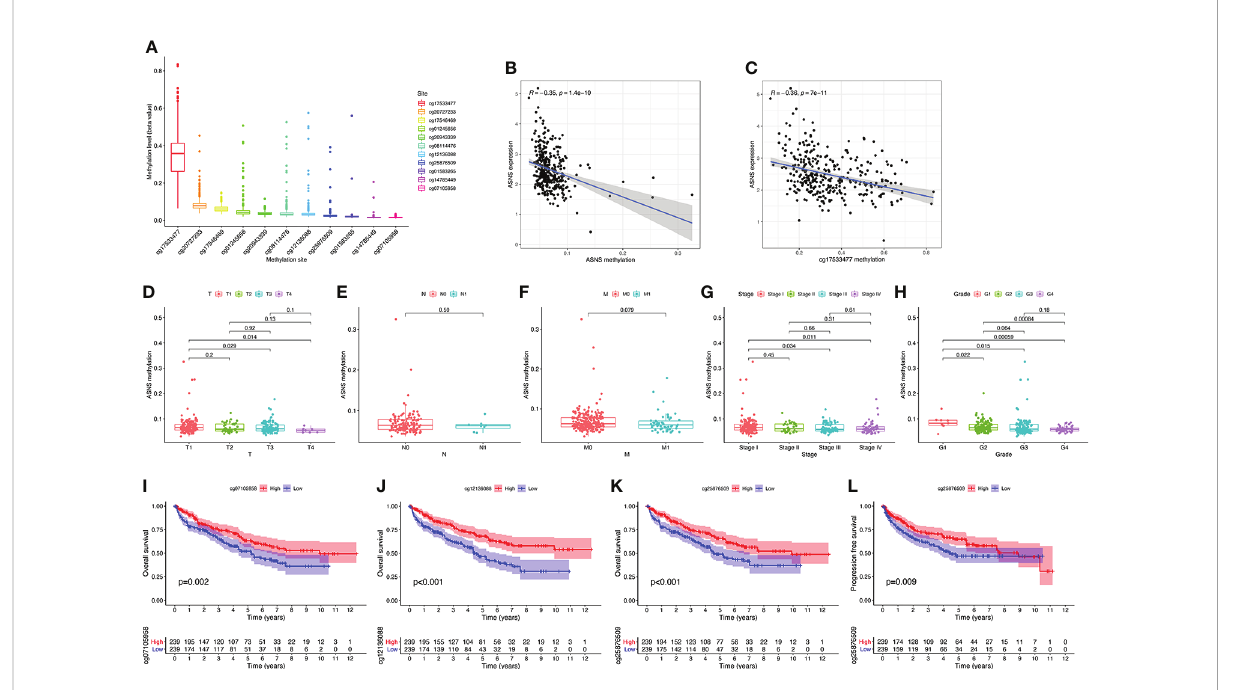
FIGURE 4 DNA methylation analysis of ASNS . (A) Methylation levels at different sites of ASNS . (B, C) The relationship between ASNS expression level and methylation level. (D – H) ASNS methylation in samples strati fi ed by T stage, N stage, M stage, neoplasm histological grade, and pathological stage. (I – L) Methylation levels of ASNS on the prognosis of ccRCC (OS and progression-free survival